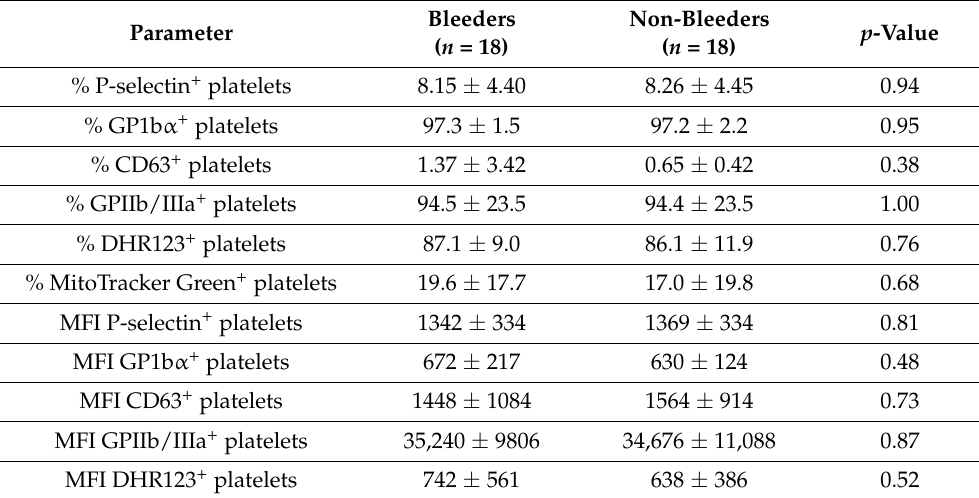
Table 7. Flow cytometric analysis of platelet receptor expression and oxidative stress in LVAD patients with and without NSB at the timepoint of bleeding